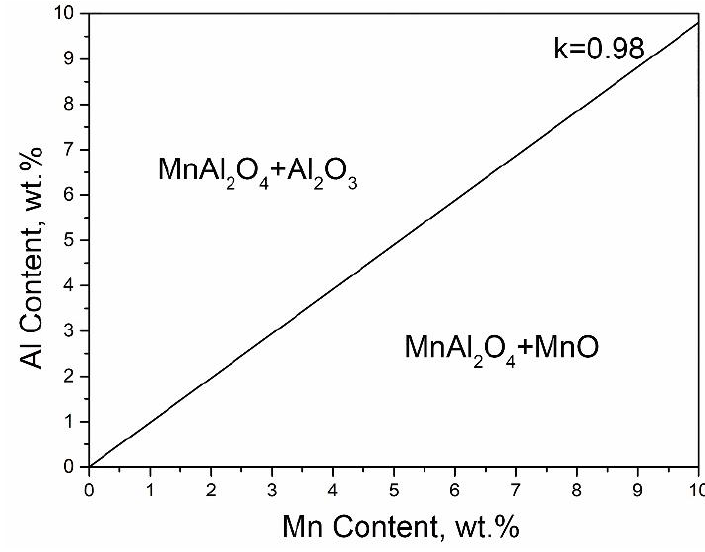
Figure 8. E ff ect of Al / Mn on the type of Figure 8. Effect of Al/Mn on the type of oxides.